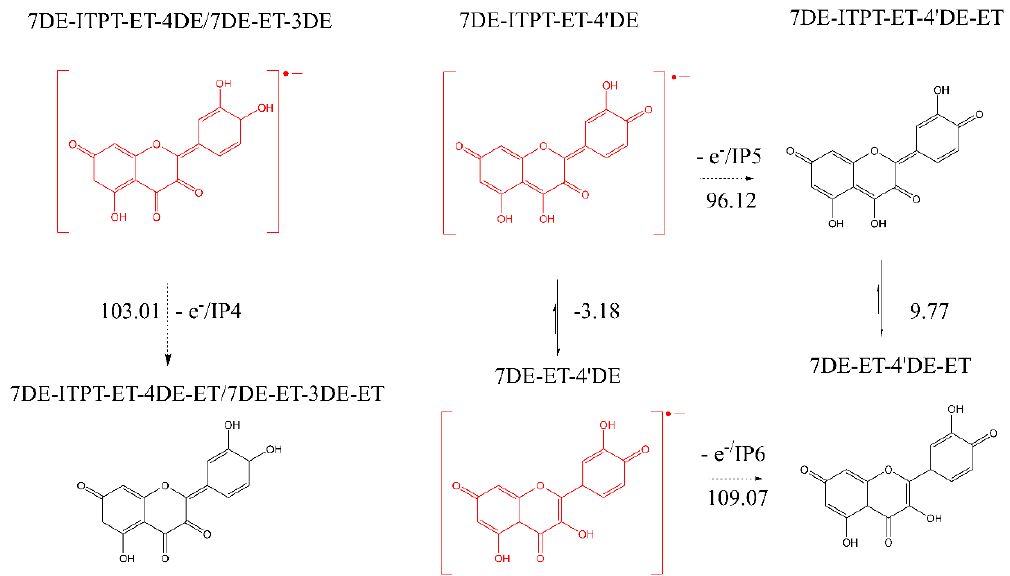
Figure 6. The enthalpy requirement (in Kcal/mol) of the second electron donation from the three conformers of the Q radical to form the corresponding quinone. Int. J. Mol. Sci. 2020 , 21 , x FOR PEER REVIEW